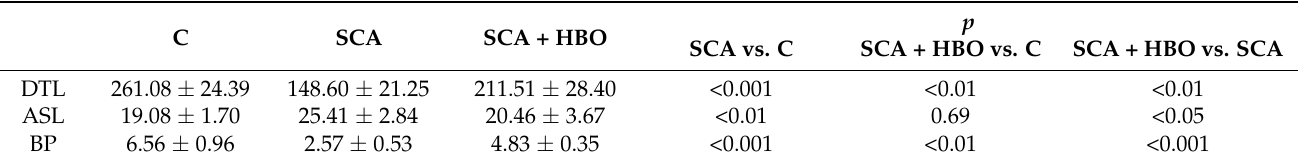
Table 1. The number of branching points, dendrite total length, and average segment length in the neurons of control, SCA and HBOT brain